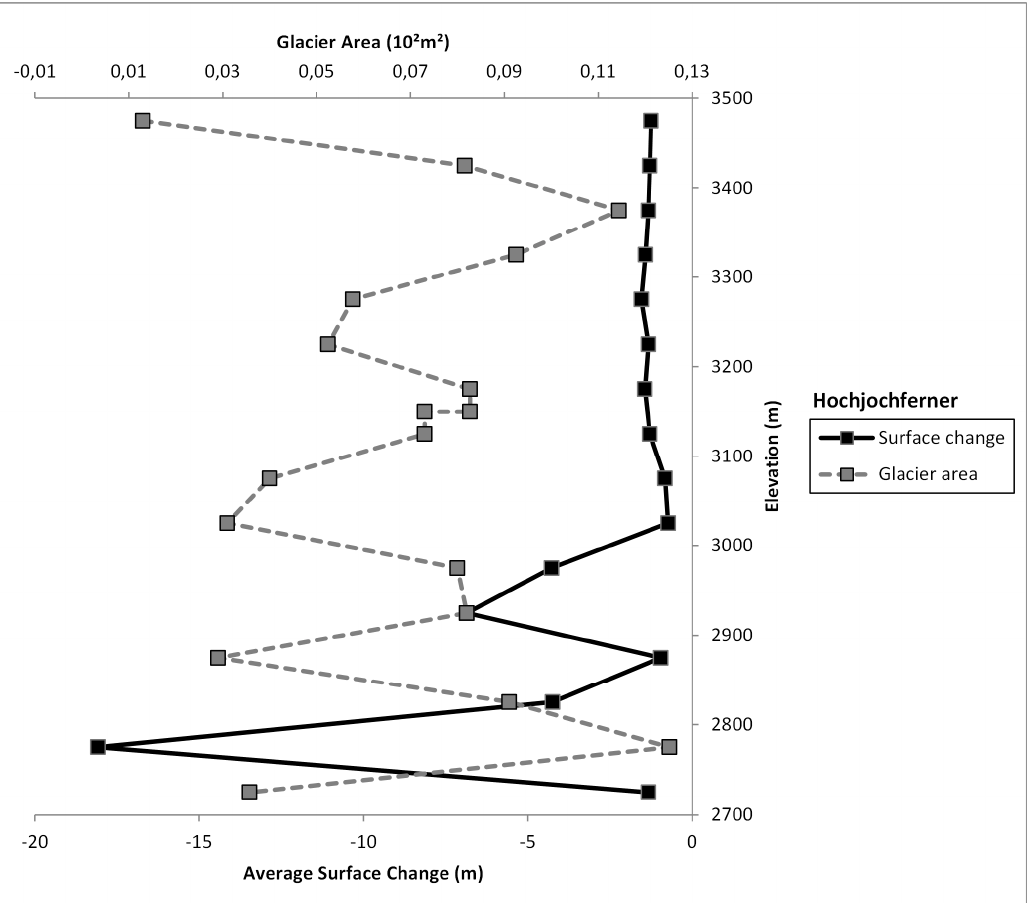
Figure 11. Volume change of Hochjochferner autumn 2014–autumn 2015.